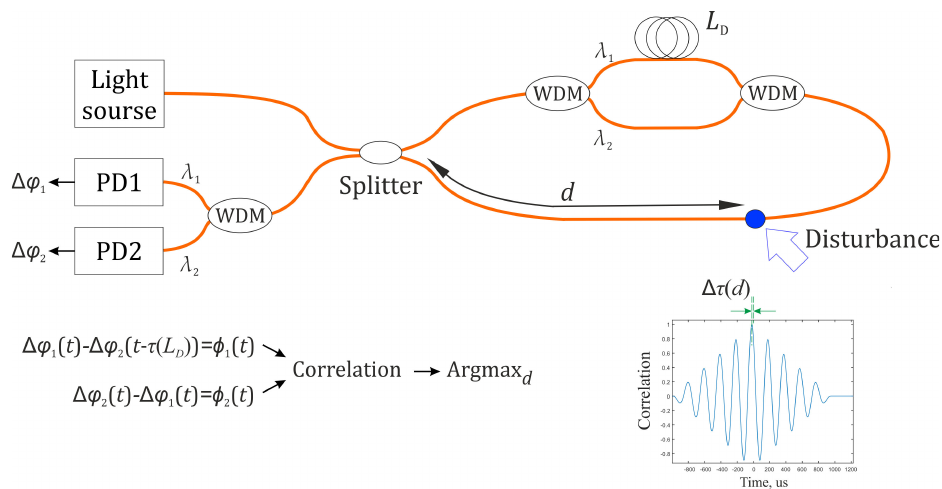
Figure 2. Diagram of a time delay estimation method